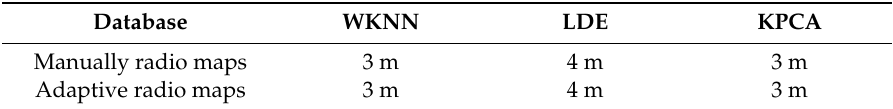
Figure 17. Dynamic positioning results of Experiment 1. Table 1. Positioning error with confidence probability 90% of three algorithms for two different databases in Experiment 1.